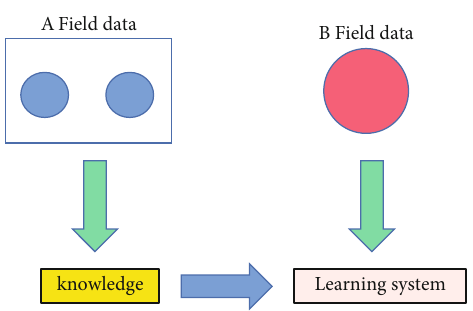
Figure 6: Neural network learning and training process.